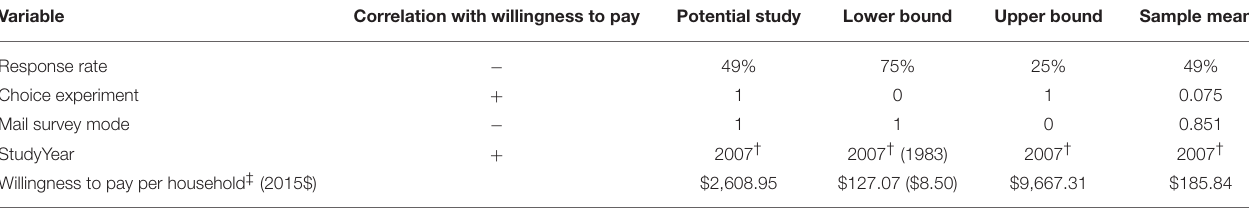
TABLE 3 | Meta-regression results applying Richardson and Loomis (2009).